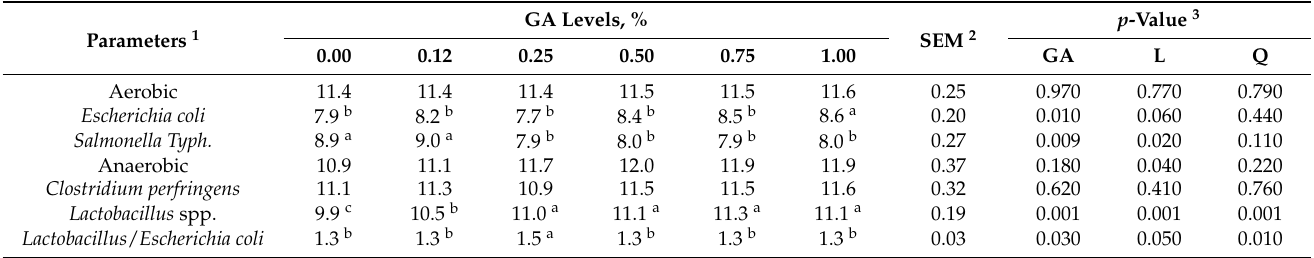
Table 7. Effect of gum Arabic (GA) on cecal microbiota of male broiler chickens on d 10 of